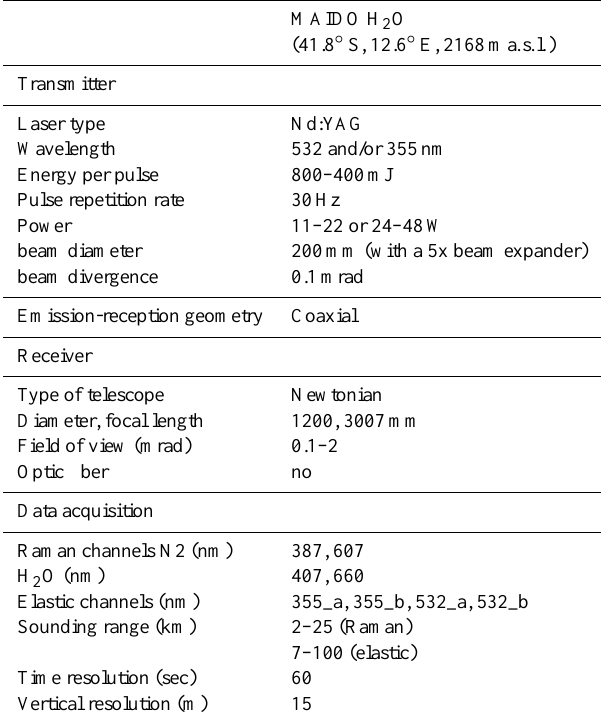
Table 2. Transmitter and receiver characteristics of the MAIDO- H 2 O lidar